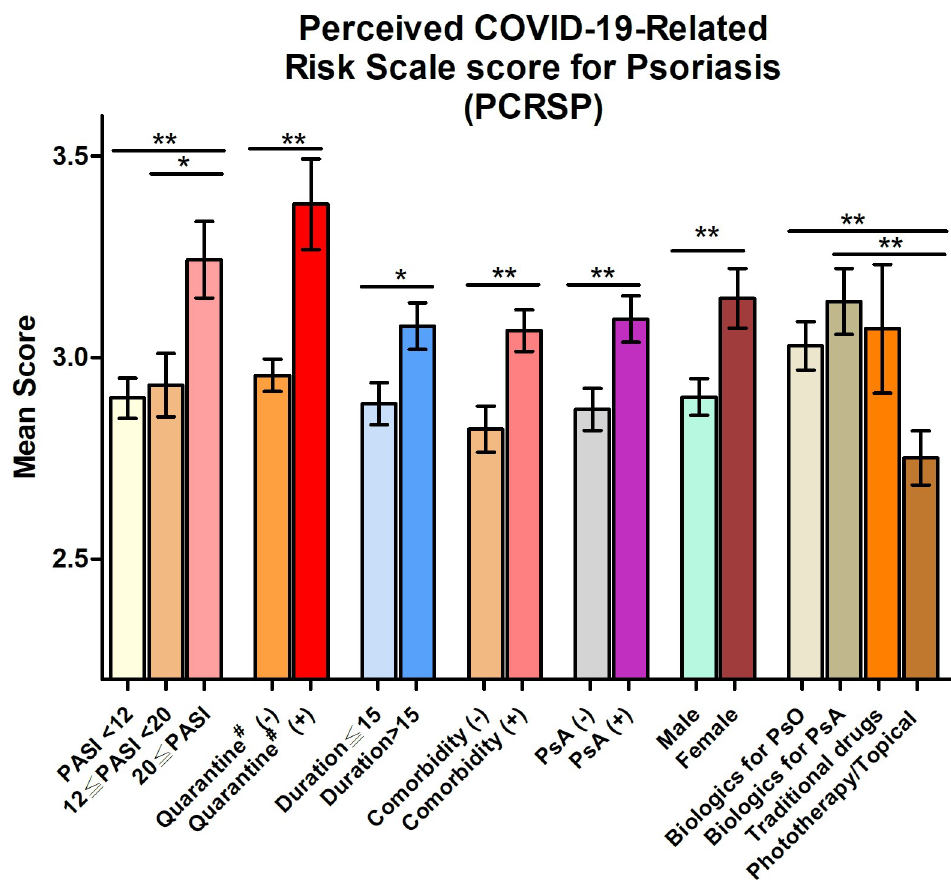
Fig 1. Perceived COVID-19-Related Risk Scale score for Psoriasis. Perceived COVID-19-Related Risk Scale score for Psoriasis stratified by demographic and psoriasis disease characteristics. PASI, Psoriasis Area and Severity Index, PsA, psoriatic arthritis, PsO, cutaneous psoriasis. Bars for each estimate indicate the standard error of the mean. # Friends or a family member with or without quarantine experience. � P < 0.05; �� P < 0.01, ��� P < 0.001. Comparisons between groups were performed using the Mann–Whitney U test except for the subgroups that were stratified by PASI and treatment modalities, assessed using the Kruskal–Wallis test.